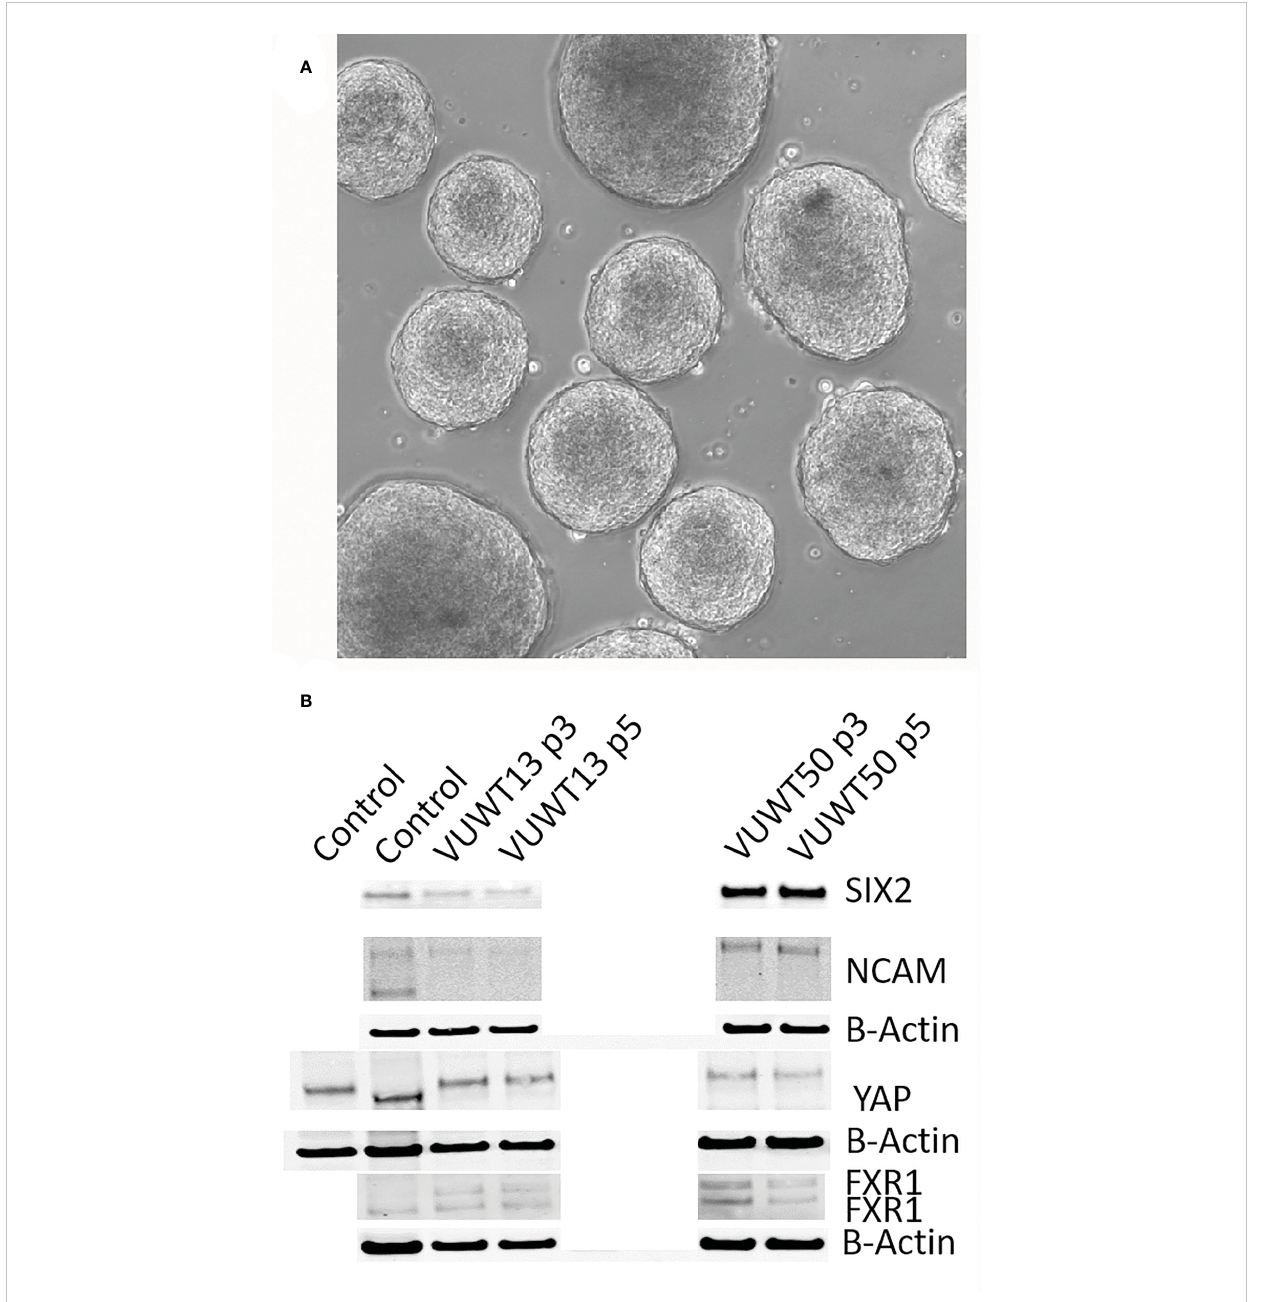
FIGURE 7 Cultured tumor cells readily form spheroids in the current medium conditions. (A) VUWT13 cells form spheroids in wells of non-adherent culture plates and could be maintained with passaging. (B) Immunoblot analysis demonstrated the stable retention of expression of Wilms tumor markers in spheroids from VUWT13 and VUWT50 cells that were dissociated and re-aggregated through several cycles. HEK293 or whole mouse embryonic kidney lysates were used as